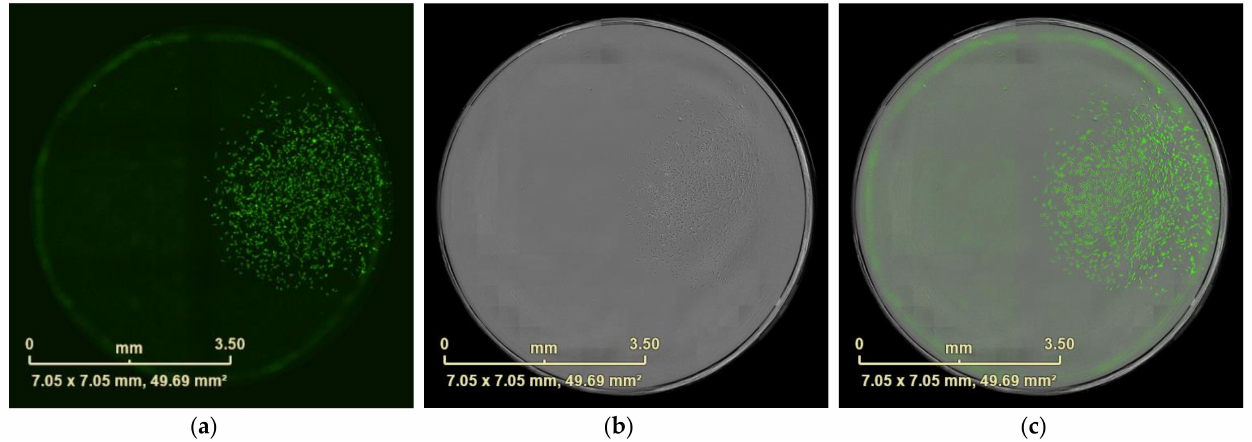
Figure 12. Uninteresting cells eliminate with tips and scraper. Use cell scraper to eliminate the cells at distant location from the marked clone. After that, eliminate the cells that closely surround the marked clone and on the edge of the well care- Figure 6. Well with one monoclonal cell only. Image from 96-well plate scanned after 12 days incubation. ( a ) Expression fully by using the pipette tips. ( a ) Cell elimination by using tips in 96-well plate well. ( b ) Cell elimination by using cell of GFP in cells detected by eGFP fluorescence. ( b ) Bright field images ( c ) Overlap of fluorescence image with bright field scraper in 6-well plate well. ( c ) Cell elimination by using tips in 6-well plate well. image. Scale bars represent 3.5 mm.